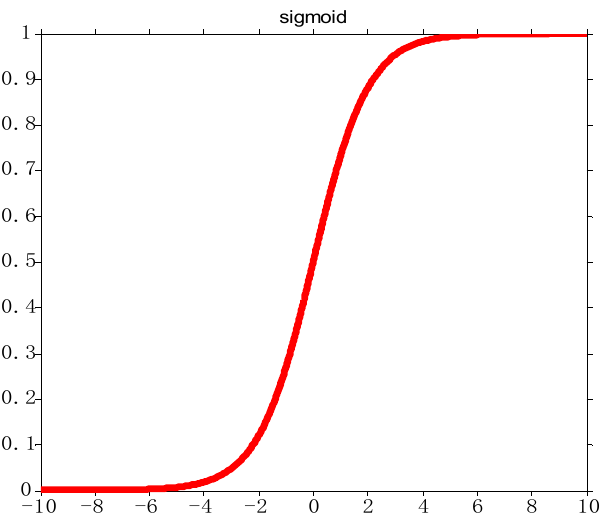
Figure 4. Inertial weight operator function.